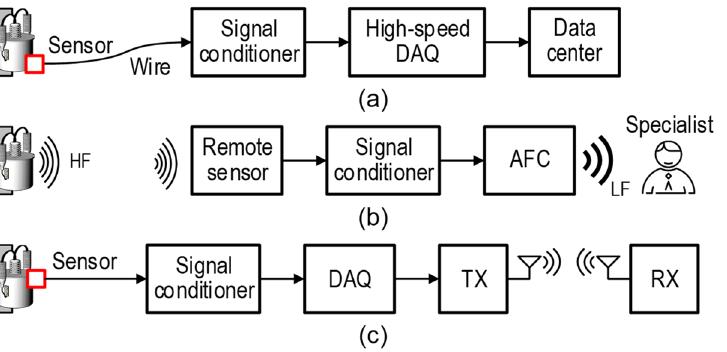
Figure 2. Block diagrams of conventional monitoring systems: ( a ) wired monitoring for large-scale transformers, ( b ) remote and ( c ) wireless monitoring for distribution transformers.